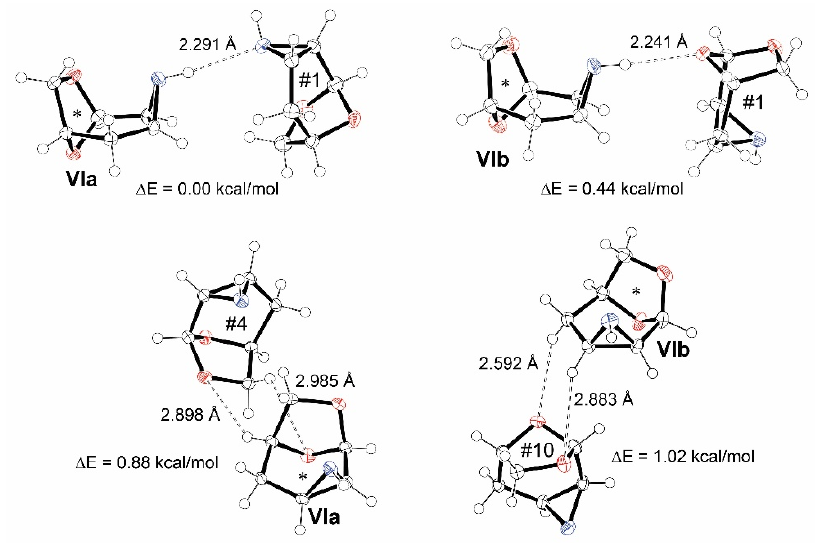
Figure 6. ORTEP presentation of the strongest intermolecular interactions found in VI . * denotes a parent molecule.